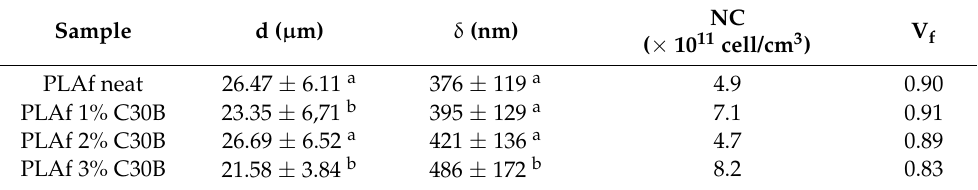
Table 2. Cell size (d), wall thickness ( δ ), cell density (NC) and void fraction (V f ).